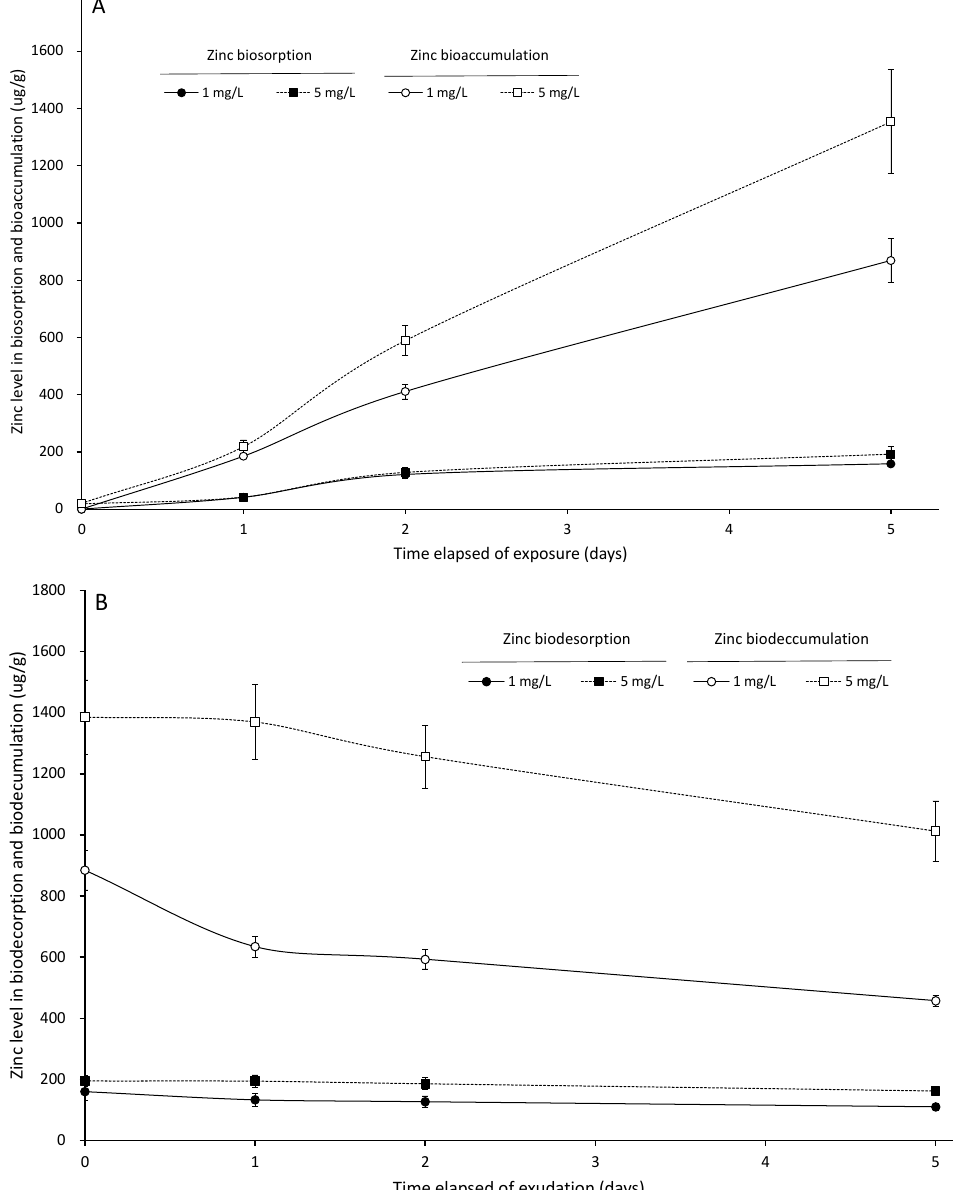
Figure 3. The zinc biosorption and bioaccumulation ( µ g/g) of S. suiae exposed to 1 and 5 Zn 2+ mg/L for 1, 2, and 5 days ( A ). The zinc biodesorption and biodecumulation of S. suiae exposed to 1 and 5 Zn 2+ mg/L for 1, 2, and 5 days ( B ). The chl-a content was 0.610 ± 0.025 mg/g in the control, and it significantly decreased with the increase in the ambient lead and zinc concentrations and exposure times ( p < 0.05). S. suiae was exposed to 1 and 5 Pb 2+ mg/L for 5 days, and the chl-a contents were 0.361 ± 0.023 and 0.251 ± 0.024 mg/g, respectively. There were significant differences in each exposure time ( p < 0.05). S. suiae was exposed to 1 and 5 Zn 2+ mg/L for 5 days, and the chl-a contents were 0.552 ± 0.009 and 0.331 ± 0.023 mg/g, respectively (Figure 4). There were significant differences in each exposure time ( p < 0.05). The seaweed was exposed to 5 mg/L lead and zinc for 5 days, and the chl-a decreasing percentage was 41.15% in 5 mg/L lead and 54.26% in 5 mg/L zinc (Figure 3).